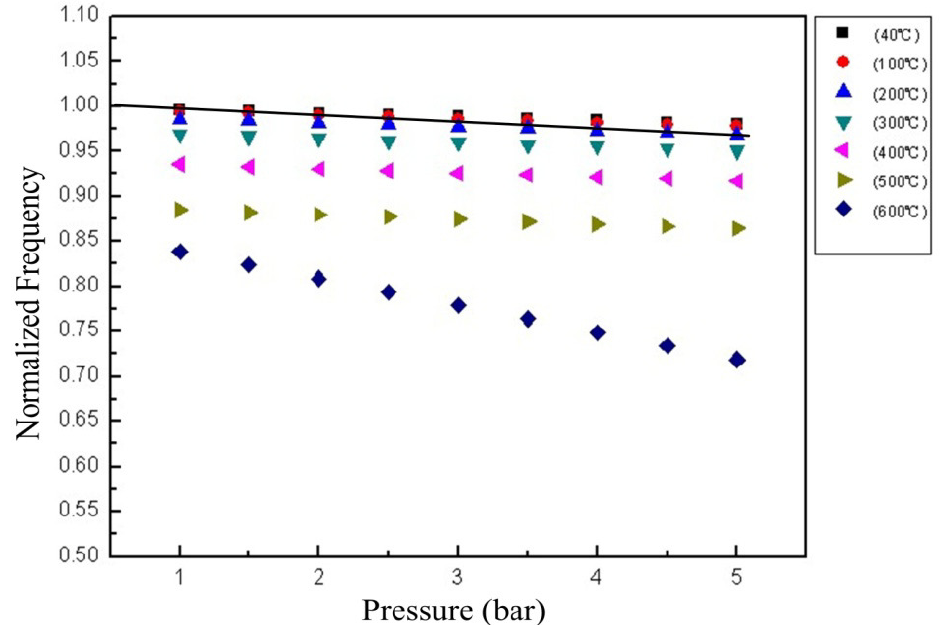
Figure 13. Normalized frequency of the sensor as a function of temperature and